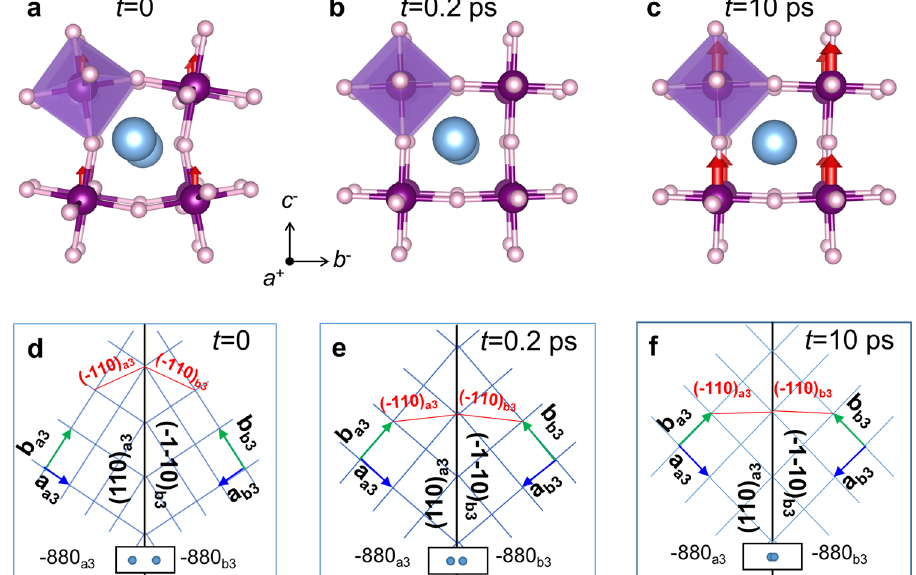
Fig. 5 Evolution of the orthorhombicity and Jahn – Teller distortion in the LaMnO 3 freestanding fi lm. a – c Schematic of the photoinduced structural change at ( a ) t = 0, ( b ) t = 0.2 ps and ( c ) t = 10 ps due to the change of MnO 6 octahedral tilt and La displacement. The red arrows in the ( a ) and ( b ) represent the spin order. d – f Schematic of evolution of the orthorhombicity ( a / b ratio) of a pair of twin variants ( a + b − c − 3 and a − b + c − 3 ) at time delay ( d ) t = 0, ( e ) t = 0.2 ps and ( f ) t = 10 ps in the [001] projection. Note, a + b − c − 3 and a − b + c − 3 have the (110) re fl ection twinning relationship in which (110) a3 || ( − 1 − 10) b3 (twin boundary is indicated by the black line). The subscripts a3 and b3 represent twin variant a + b − c − 3 and a − b + c − 3 , respectively. When a / b < 1, ( − 110) a3 is not parallel to ( − 110) b3 (red lines), resulting in the spot splitting of − kk 0 (bottom insets). When the a / b ratio moves toward the unity, spot splitting reduces and vanishes when a / b = 1 [( − 110) a3 || ( − 110) b3 ]. Note, the drawing of the lattice is exaggerated for clarity. For the complete description of twelve equivalent twin variants in the system and their corresponding diffraction patterns, please see Supplementary Fig.